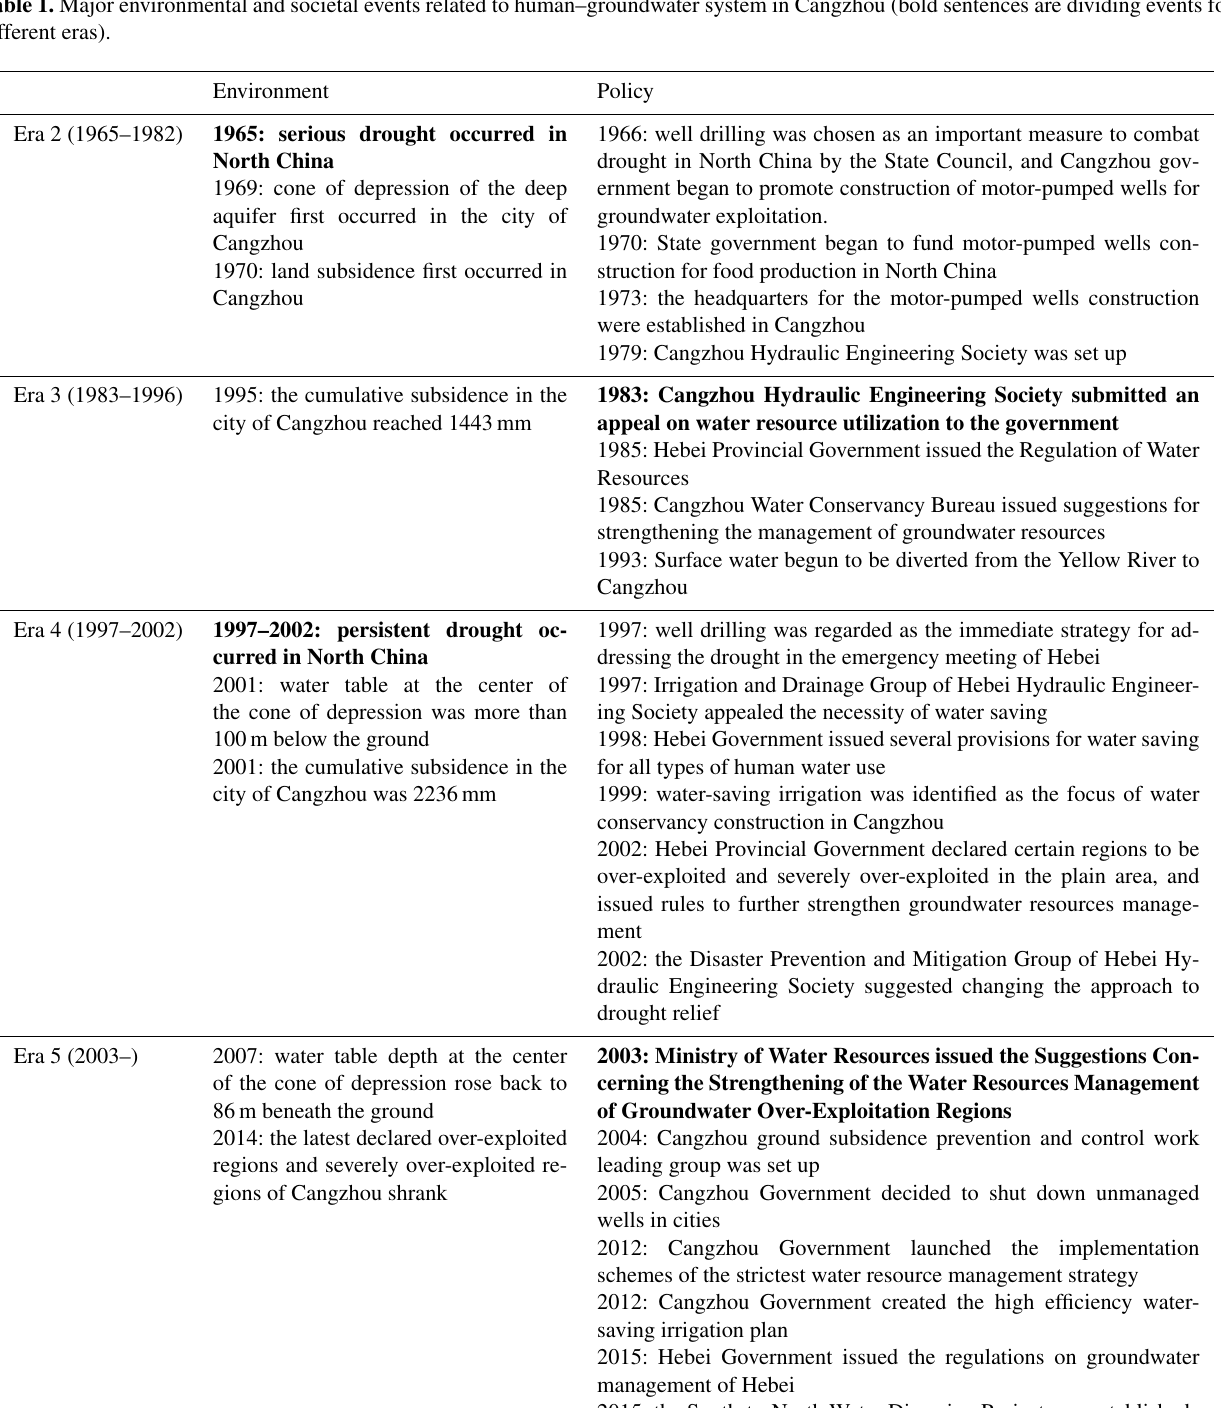
Table 1. Major environmental and societal events related to human–groundwater system in Cangzhou (bold sentences are dividing events for different